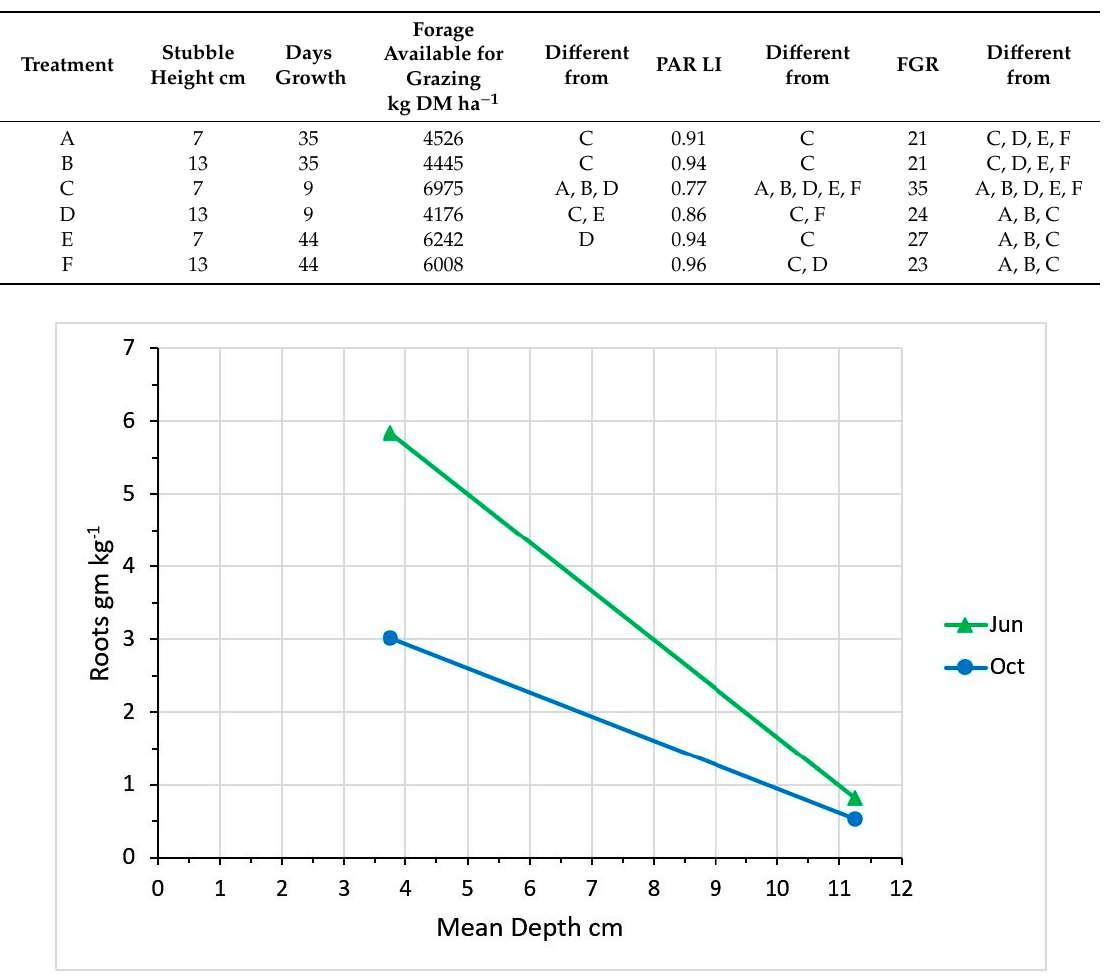
Table 3. Simulated pasture harvest treatments’ impact on the total forage growth available for grazing, with light interception (LI) as a fraction of ambient PAR and average pasture forage growth rate (FGR, kg DM ha − 1 day − 1 ).